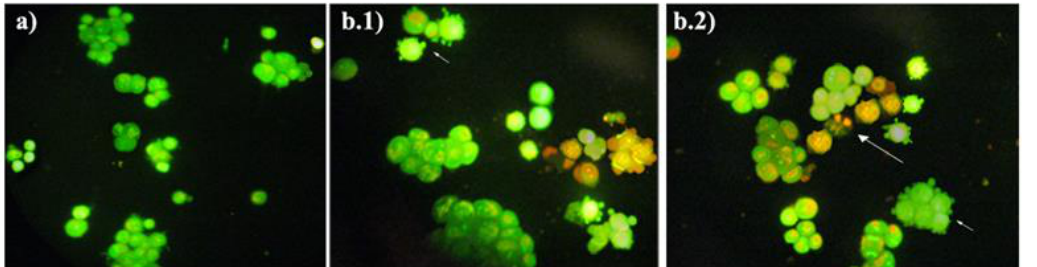
Figure 4. Morphology of HeLa cells with EtBr and acridine orange staining, revealing apoptotic stages. ( a ) Untreated HeLa cells. ( b ) Cells treated with 100 µ g/mL OIM showed early apoptotic (small arrow— b.1 and b.2 ) and late apoptotic (long arrow— b.2 )